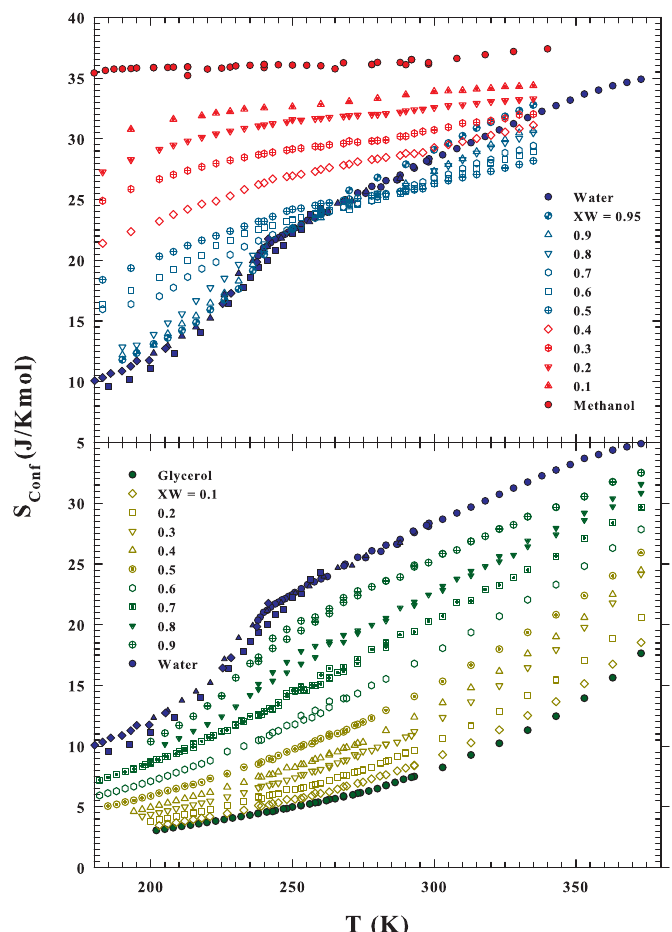
Figure 7. The solutions’ configurational entropies evaluated according with the Adam–Gibbs are proposed as a function of the temperature. At the top are the water-methanol data, and that of water–glycerol are at the bottom. As observed in the methanol solutions, their behavior at higher T ( T > 260 K) is not continuous with Xw : the pure water S conf is higher than that of so- lutions for the X W range 0.9–0.4. As explained, it is due to the hydrophobic effect as proposed by the NMR